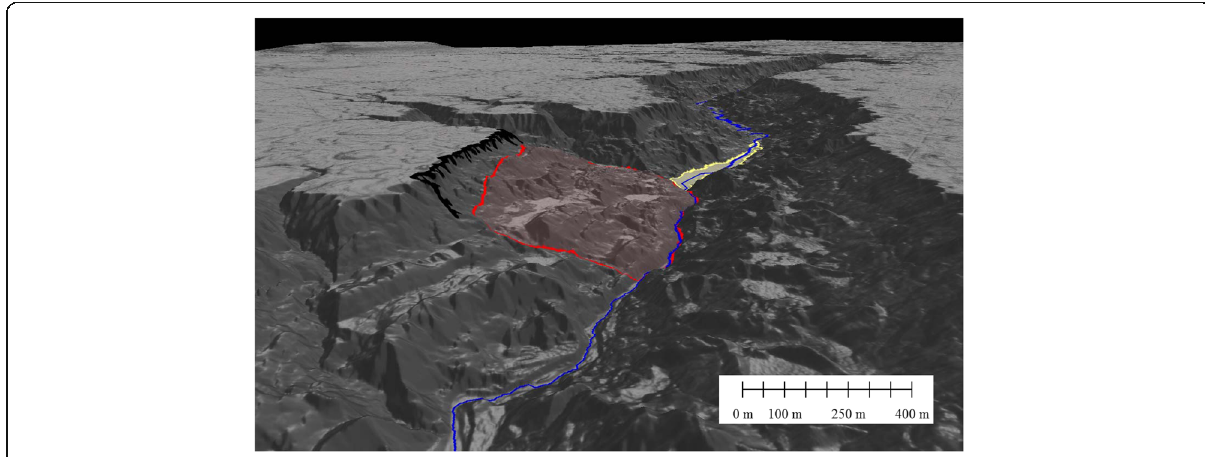
Fig. 5 Oblique perspective of the Eureka River landslide and dam, using a Digital Elevation Model derived from lidar data (dated September 26, 2013; source: Government of Alberta, reproduced with permission), at 2-times vertical exaggeration. The lidar data was collected approximately 4 years after the landslide lake had drained. The red polygon delineates the landslide colluvium, and the black hatched line delineates the landslide ’ s main scarp. The yellow polygon delineates an area of thick lacustrine sediment accumulation (up to 8 m), deposited within the landslide lake basin. The blue line traces the post-landslide dam Eureka River. The scale bar is accurate at the downstream (proximal) edge of the landslide